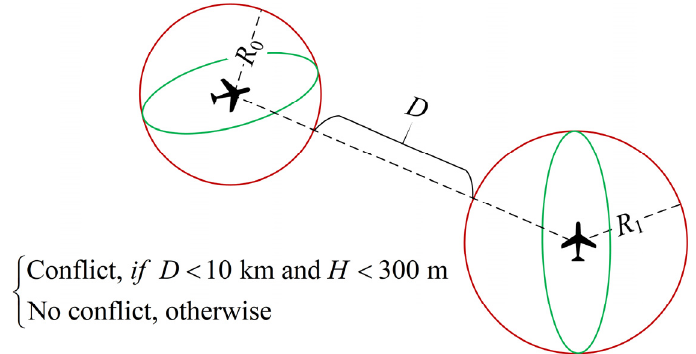
Figure 5. Conflict detection under uncertain conditions.